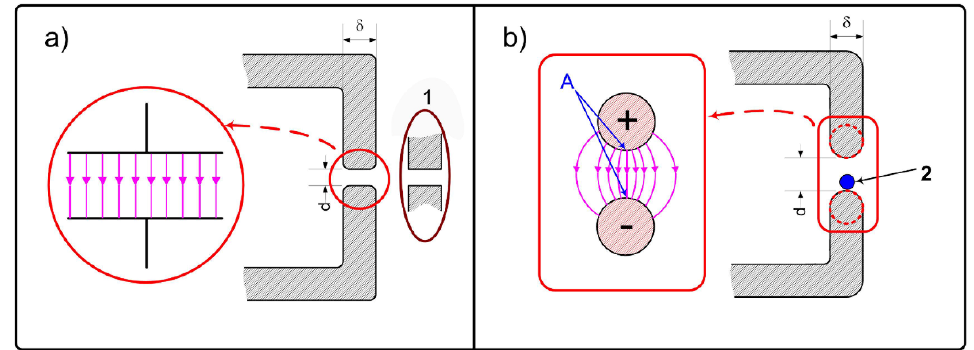
Figure 2. The cross section of the slot in the side wall of the microwave waveguide and the distribution of the electric field in the slot in the approximation of: ( a ) a parallel plate capacitor, the number 1 denotes the cross section of the slot with non-rounded corners, and ( b ) a parallel-wire line, the number 2 denotes the position of the capillary or HCF in the slot during the experiment. Insets with a red border show the approximate distribution of electric field lines in the cross section of the slot. The letter A denotes the regions with the maximum electric field.